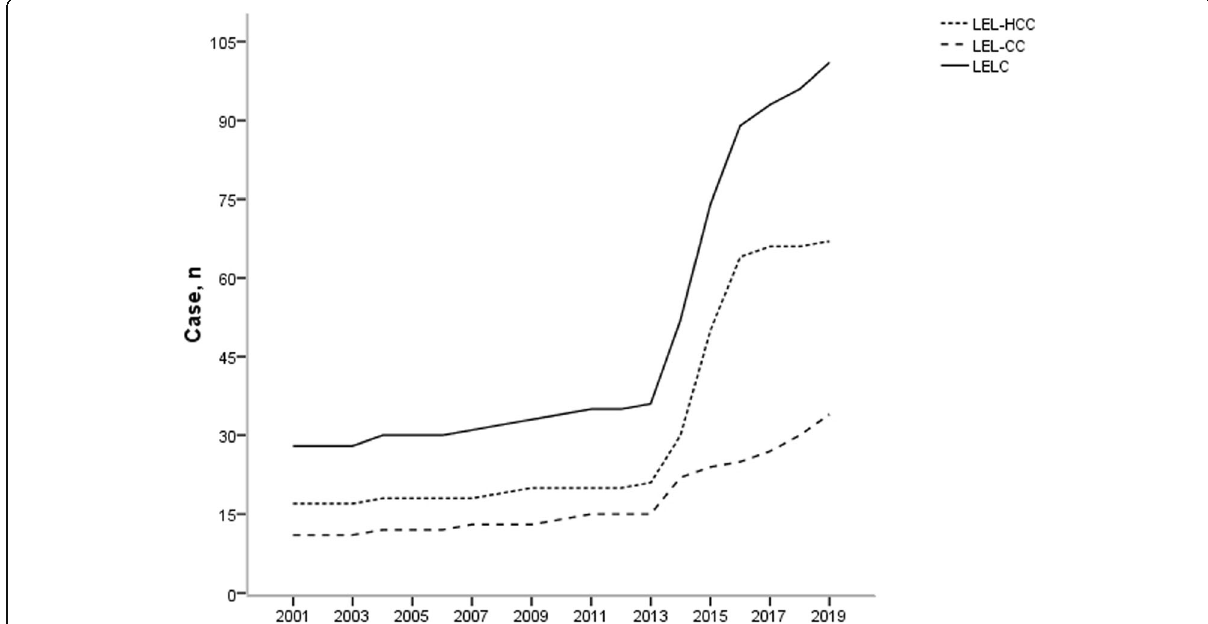
Fig. 1 Number of reported cases of lymphoepithelioma-like carcinoma (LELC). Number of cases reported in the English literature since 2001 for lymphoepithelioma-like hepatocellular carcinoma (LEL-HCC), lymphoepithelioma-like cholangiocarcinoma (LEL-CC), and both